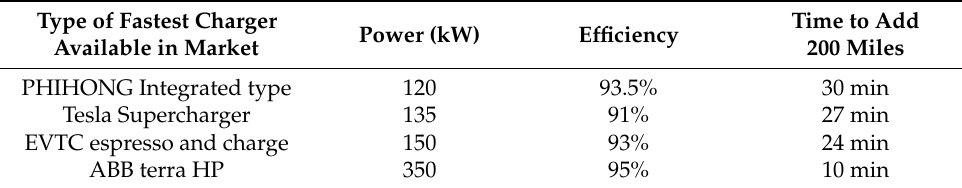
Table 1. Types of Fast Charger available as of Now